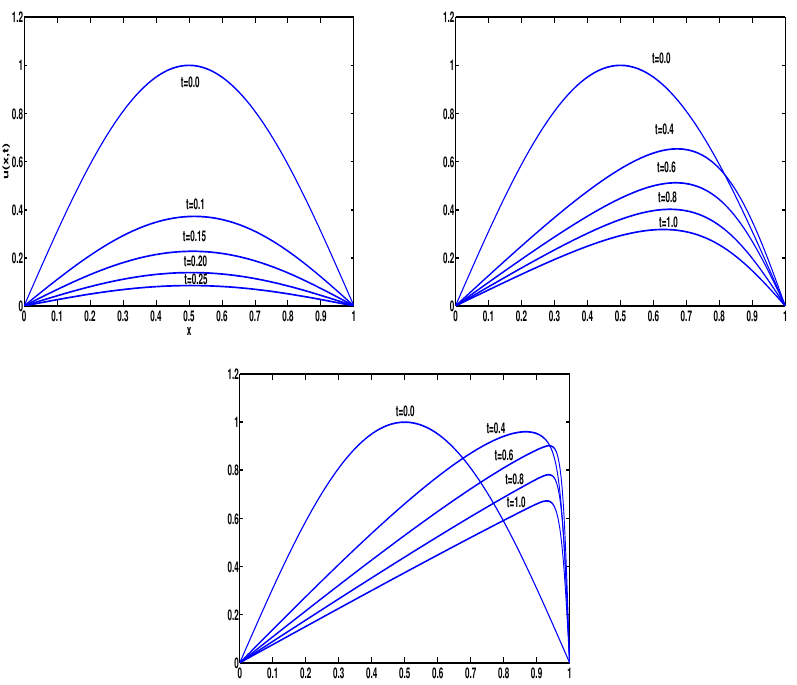
Figure 1. Physical behavior of numerical solutions u ( x , t ) for ν = 1, M = 40 (top left panel) and ν = 0.1, M = 80 (top right panel) and ν = 0.01, M = 80 (bottom panel) at different final times for ∆ t =